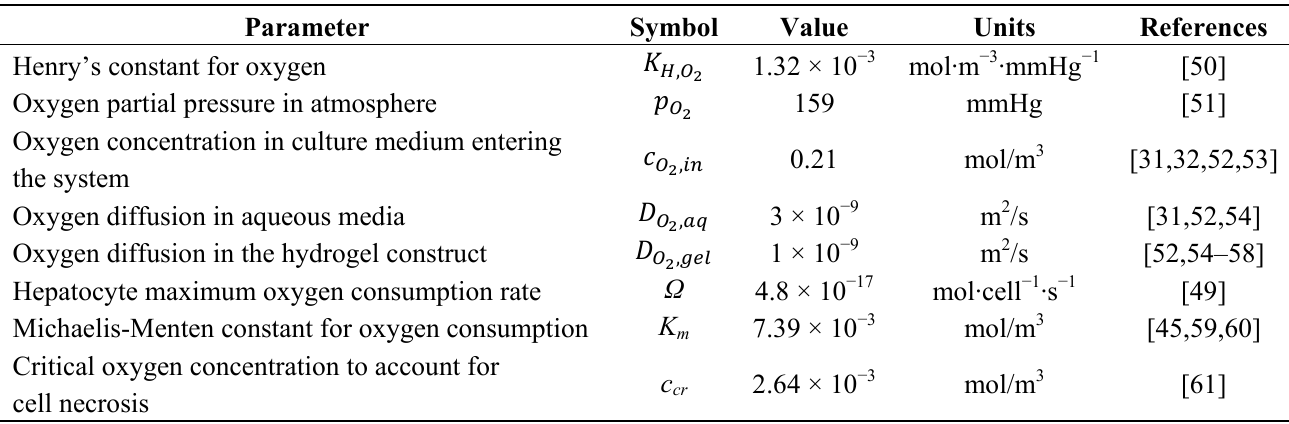
Table 3. Model parameters for oxygen transport and consumption at 37